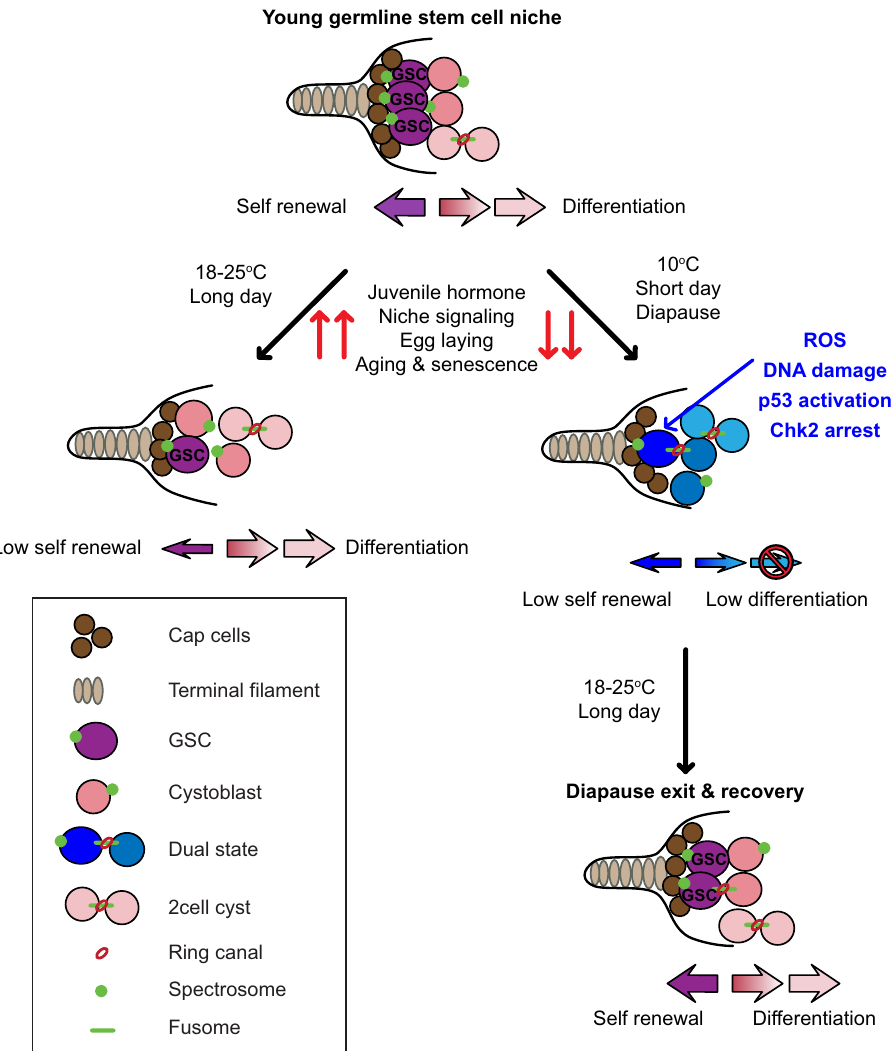
Fig. 9 Model for ovarian diapause arrest and recovery. During diapause, the GSCs enter a state of inactivity mediated by Dpp downregulation, increased incidence of ROS, DNA damage, and Chk2 activation. The low level of differentiation maintains a pool of germline cells within the germarium, which replenishes GSCs upon diapause exit. Post-diapause, Dpp signaling from cap cells is restored and re-activates GSCs to reverse the developmental